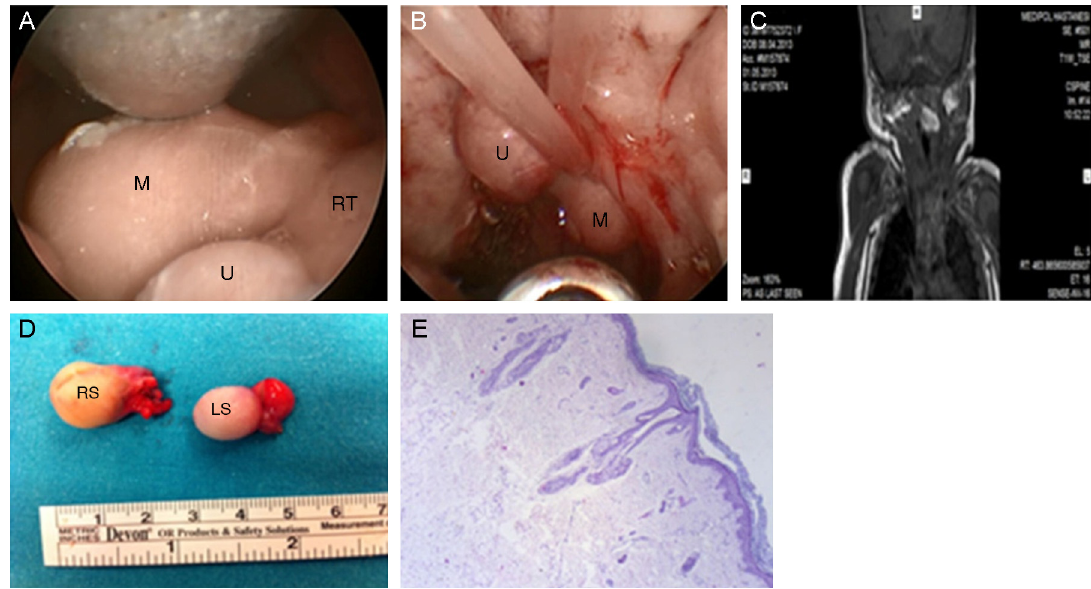
Figure 1 (A) Hairy polyp originating from the posterior pillar of the right tonsil (M, mass; U, uvula; RT, right tonsil). (B) Hairy polyp originating from the posterior pillar of the left tonsil elongating through the nasopharynx (M, mass; u, Uvula). (C) Magnetic resonance image of the hairy polyp originating from the posterior pillar of the right tonsil. (D) The excised specimens (RS, right specimen; LS, left specimen). (E) Keratinized squamous epithelium on the surface and mesenchymal tissue components, such as hair follicles lining the fibroadipose core (HE 40 × ). lateral pharyngeal wall. Female infants are six times more likely to be affected than males.